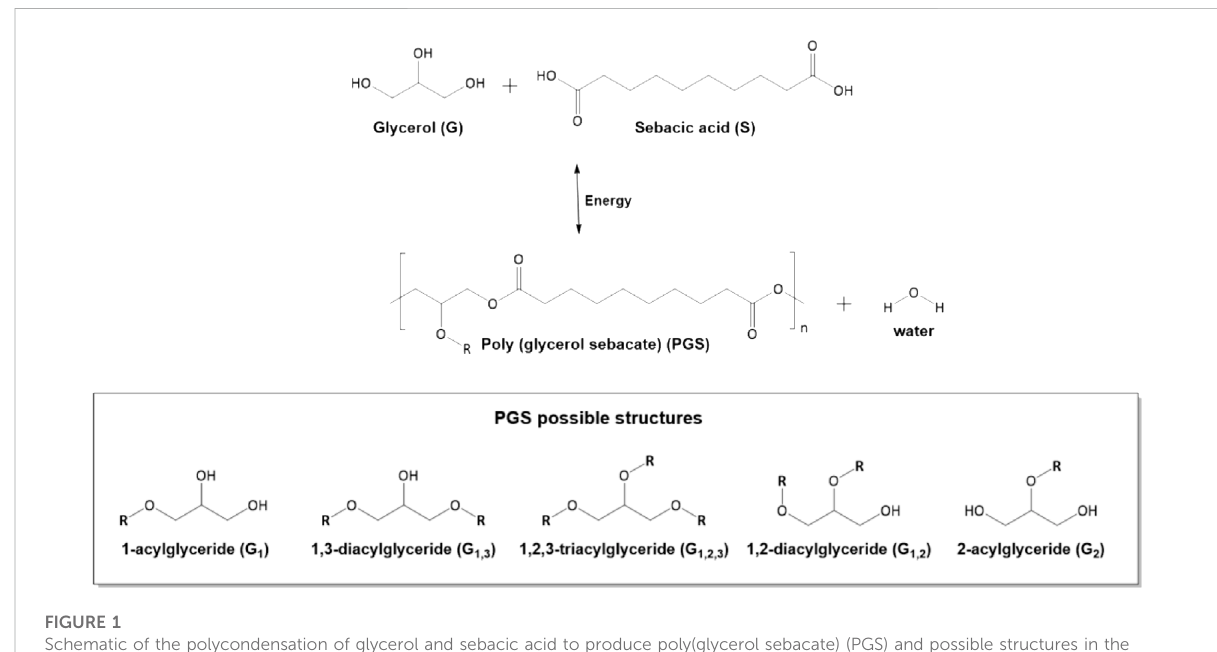
FIGURE 1 Schematic of the polycondensation of glycerol and sebacic acid to produce poly(glycerol sebacate) (PGS) and possible structures in the polymer chains. “ R ” = unde fi ned polymer